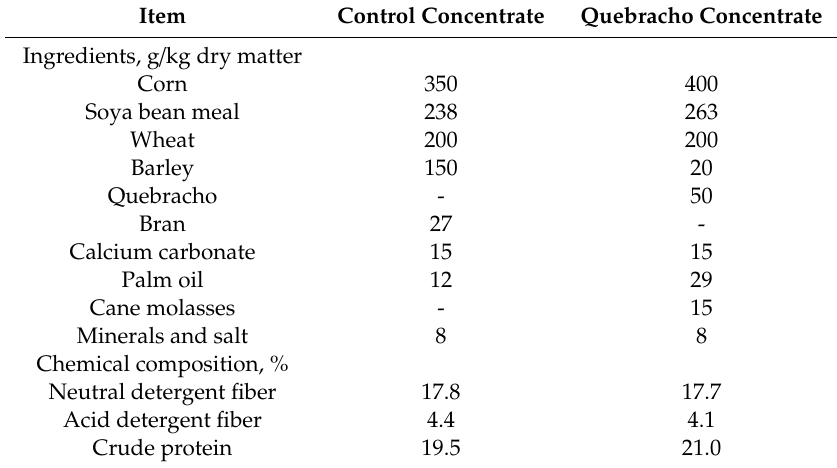
Table 1. Ingredients and chemical composition of the concentrates of the lambs.